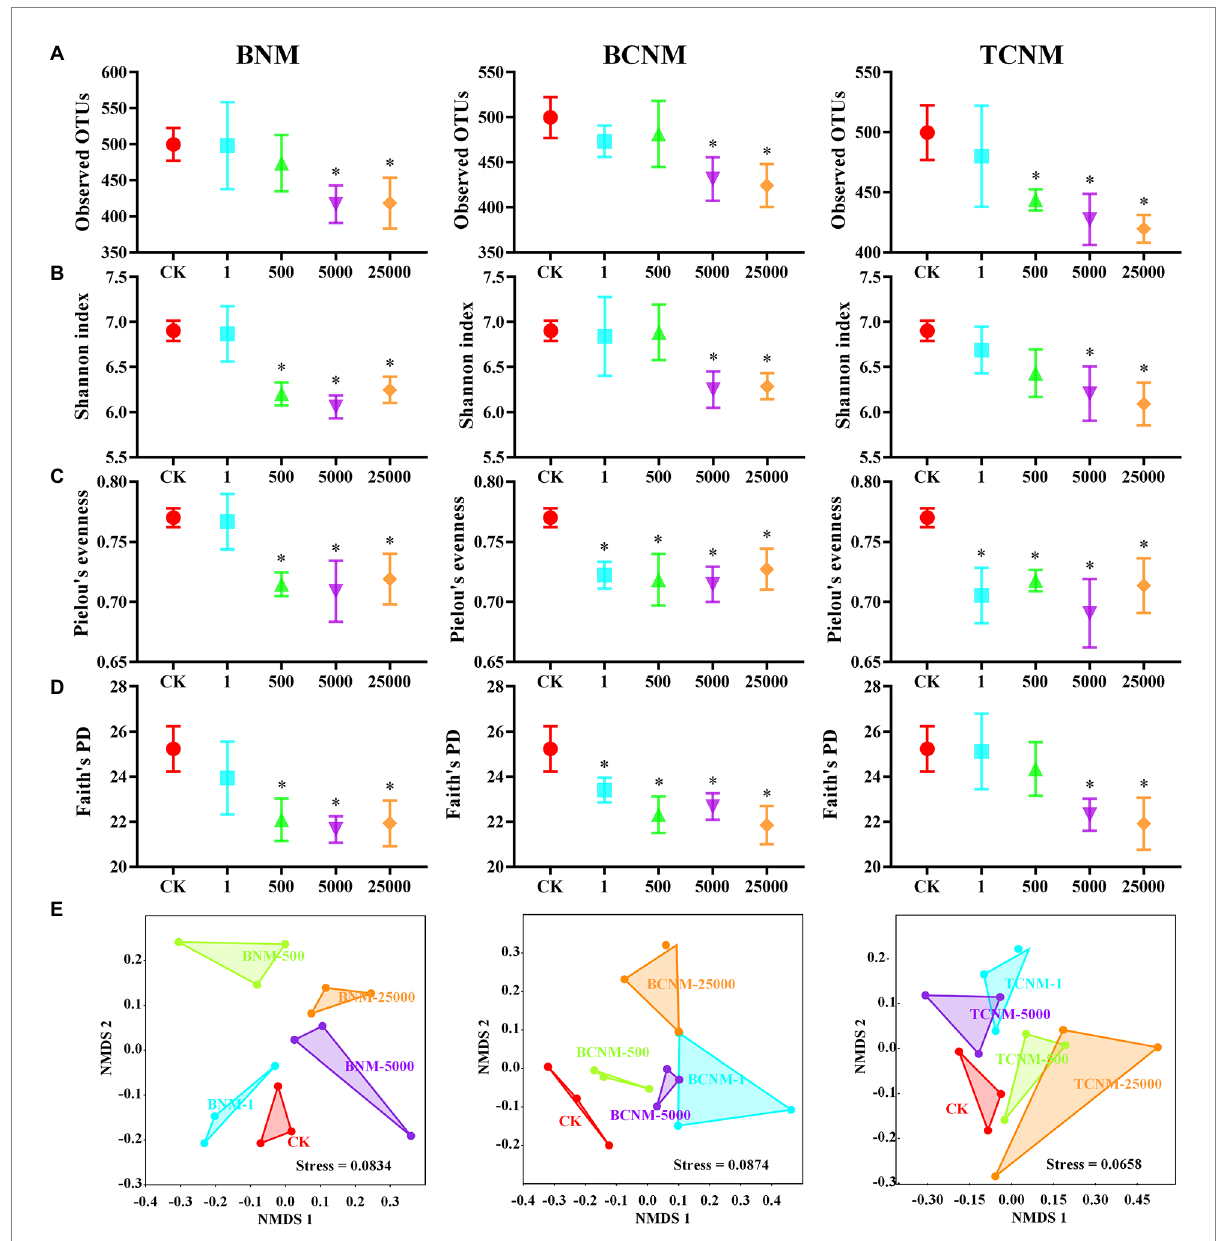
FIGURE 2 Effects of HNMs at different exposure concentrations ( μ g L − 1 ) on the α and β -diversity of the intestinal flora in mice. (A) Observed OTUs, (B) Shannon index, (C) Pielou’s evenness, (D) Faith’s PD, and (E) non-metric multidimensional scaling (NMDS) based on the Bray–Curtis dissimilarity. Values are mean values ± standard deviation ( n = 3). Differences were calculated using one-way ANOVA followed by Tukey’s post hoc test. * means significant difference compared to CK group ( p <